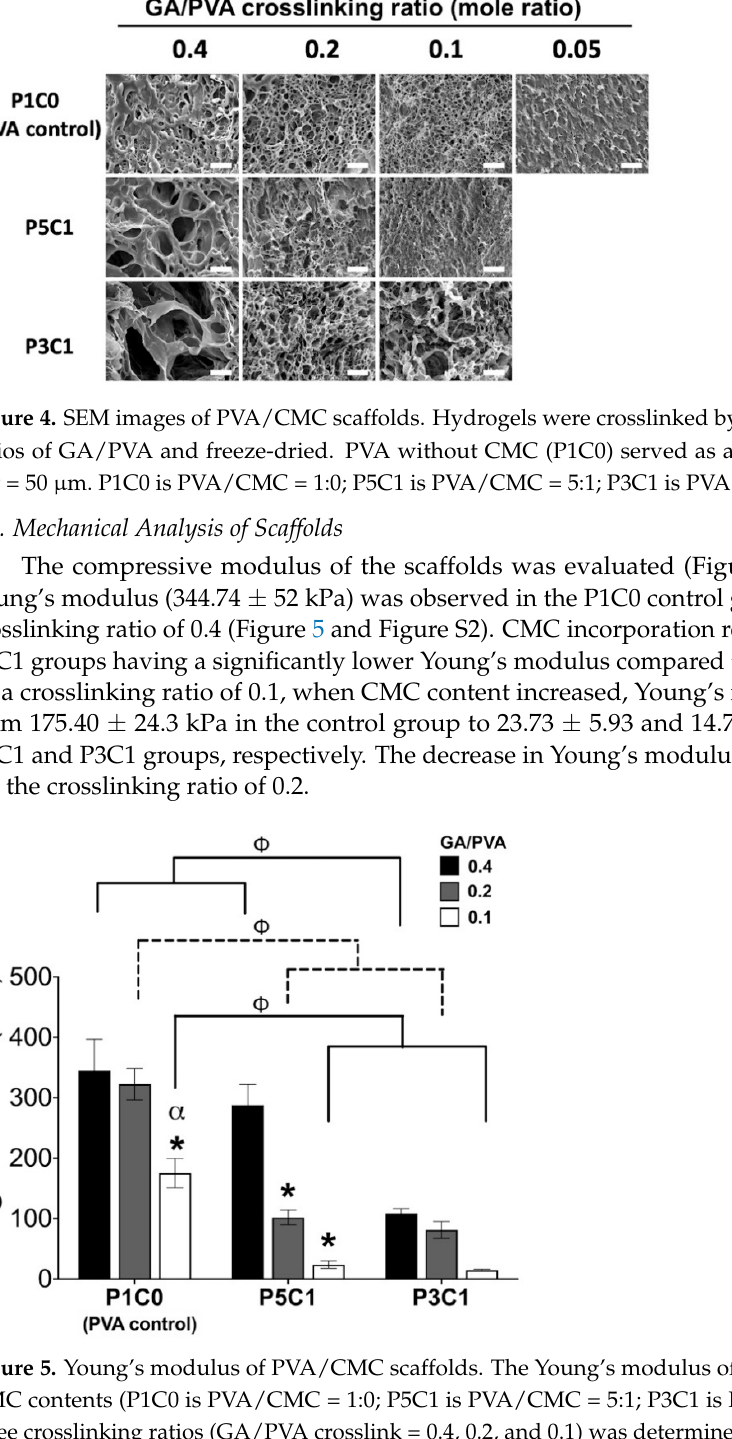
5 of 16 Figure 3. Differential scanning calorimetry ( DSC) thermal analysis of scaffolds (exo up). P1C0 con- trol, P5C1, and P3C1 scaffolds with different GA/PVA crosslinking ratios of 0.4, 0.2, and 0.1. ( A ) Heating curves and ( B ) cooling curves; dashed lines in the heating curves indicate three groups without T m peaks (GA/PVA crosslinking ratio of 0.4). The dashed line in cooling curve indicates the group without T c peak (P5C1_0.4). P1C0 is PVA/CMC = 1:0; P5C1 is PVA/CMC = 5:1; P3C1 is PVA/CMC = 3:1. 2.4. Micromorphological Assessment The porosity of PVA/CMC scaffolds was visualized by scanning electron microscopy (SEM). P1C0 control scaffolds at a GA/PVA crosslinking ratio of 0.4 displayed thick walls and small pore sizes (Figure 4). When the crosslinking ratio decreased to 0.2 and 0.1, thin-